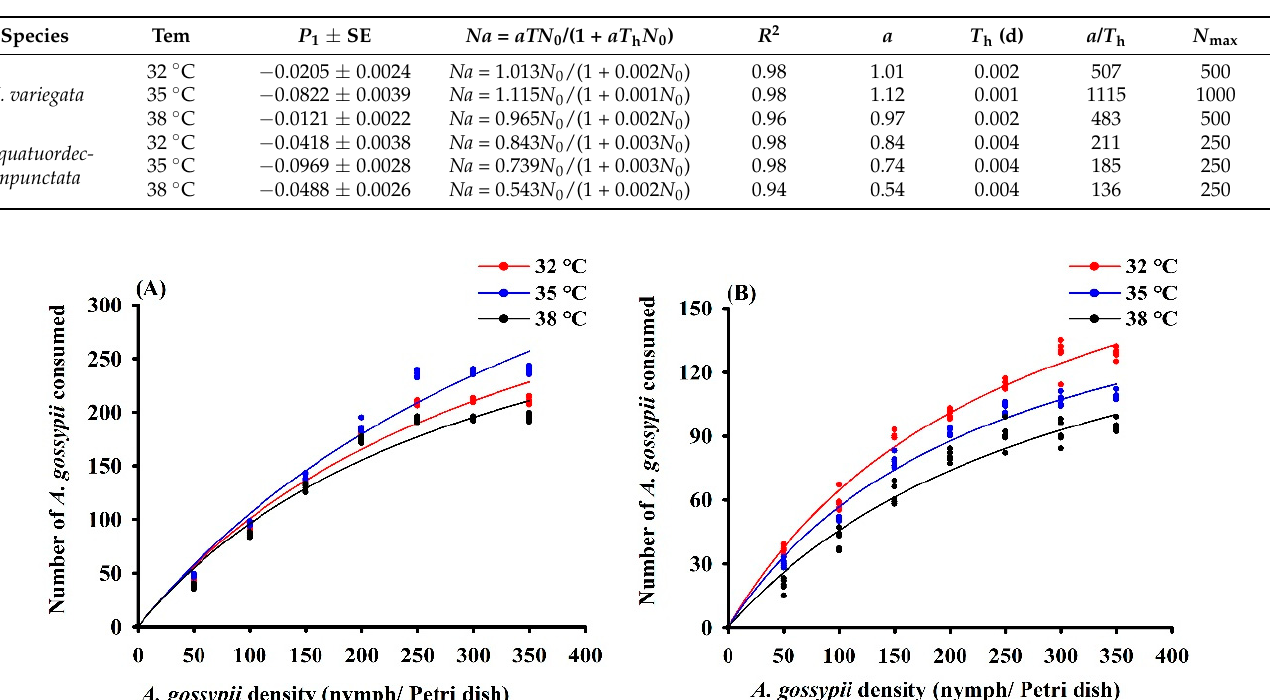
Table 1. Functional response parameters, as obtained through logistic regression, of adult female Hippodamia variegata and Propylaea quatuordecimpunctata reared on 4th instar Aphis gossypii under different temperature regimes. P 1 is the linear coefficients of the logistic regression analysis equation; Tem is the experimental temperature; a is the instantaneous searching rate; T h is the handling time. The exact structure of the functional response models is described in the text.